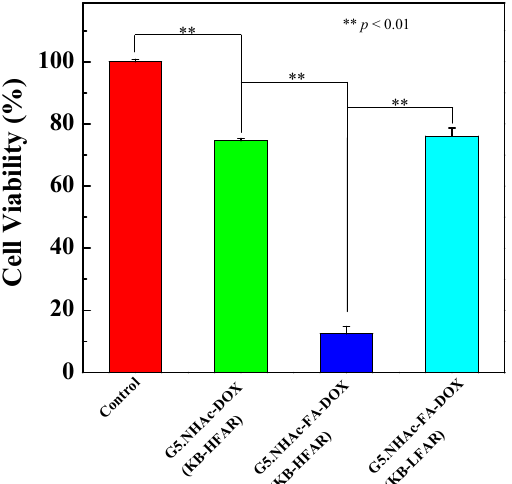
Figure 8. MTT assay of the viability of KB-HFAR cells treated with G5.NHAc-FA-DOX conjugates or G5.NHAc-DOX conjugates and KB-LFAR cells treated with G5.NHAc-FA-DOX with a DOX concentration of 50 μ M at 37 °C for 2 h.